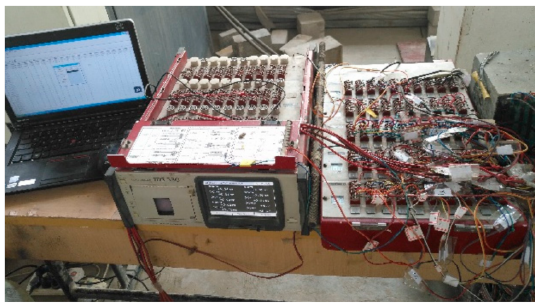
Figure 4. TDS-530 static data